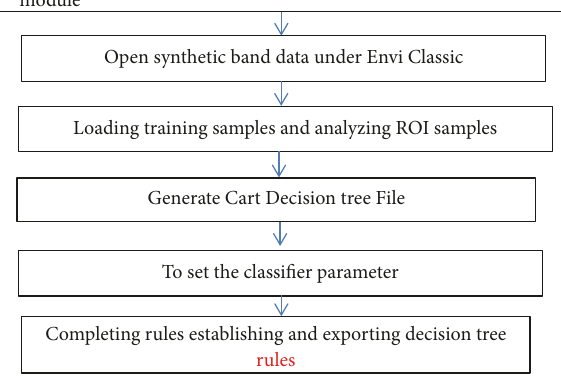
Figure 6: Flowchart of the establishment of decision tree